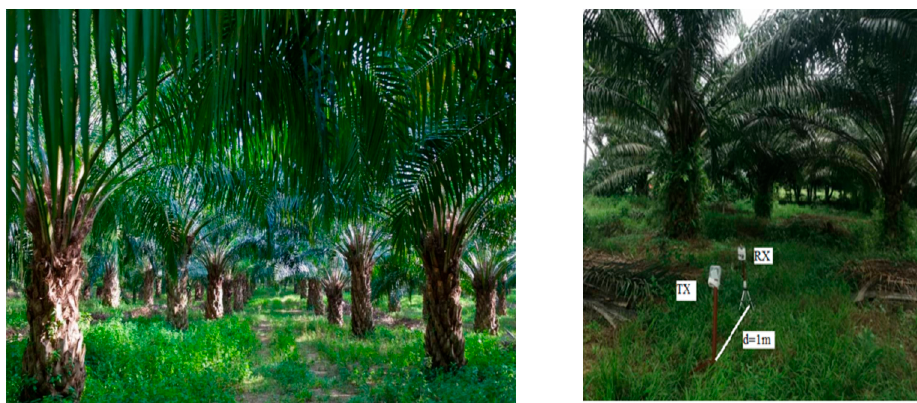
Figure 5. LOS links in between the two lines of trees ( left ); RSSI measurement ( right ).